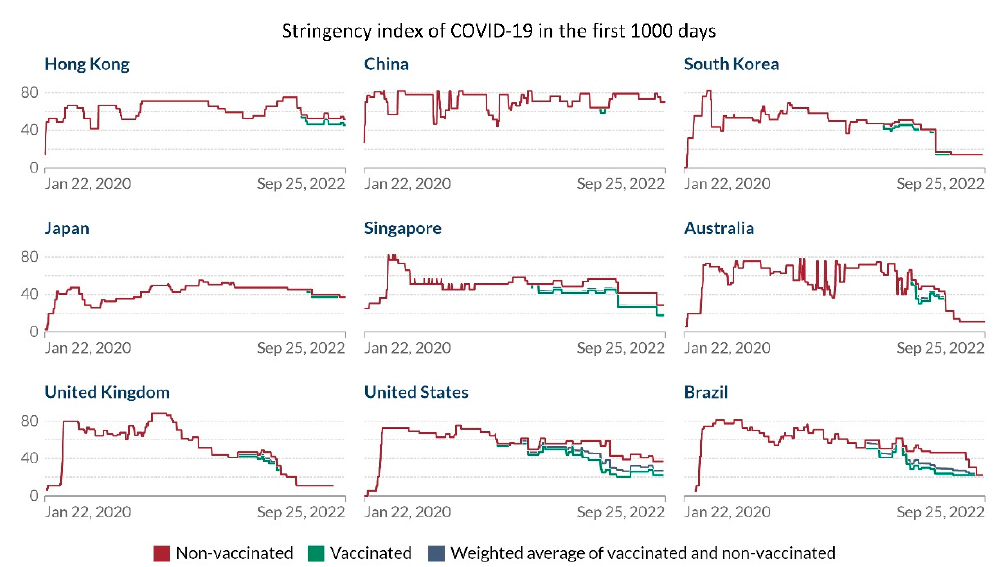
Figure 5. The evolution of the COVID-19 Stringency Index in the first 1000 days. The official announcement of the outbreak of community-acquired pneumonia in Wuhan, Hubei Province, China, was defined as day 1. The figure was generated from the website of the COVID-19 Government Response Tracker [114] and formatted for presentation.